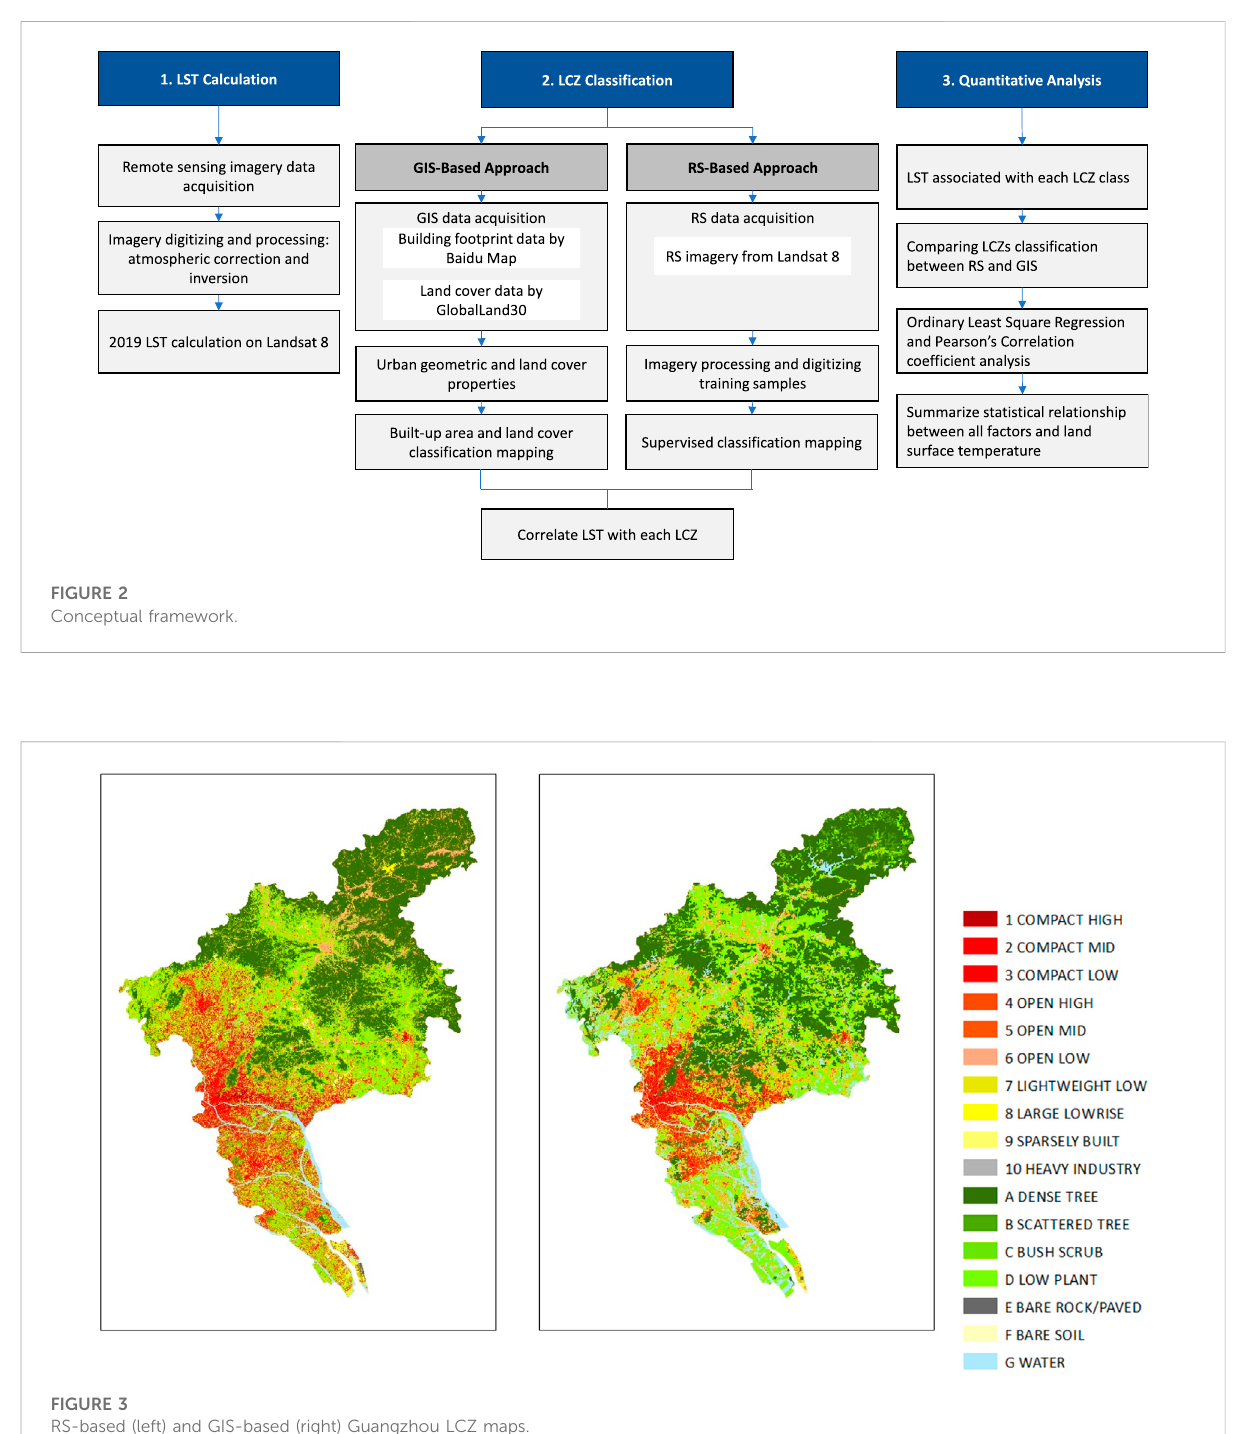
FIGURE 3 RS-based (left) and GIS-based (right) Guangzhou LCZ